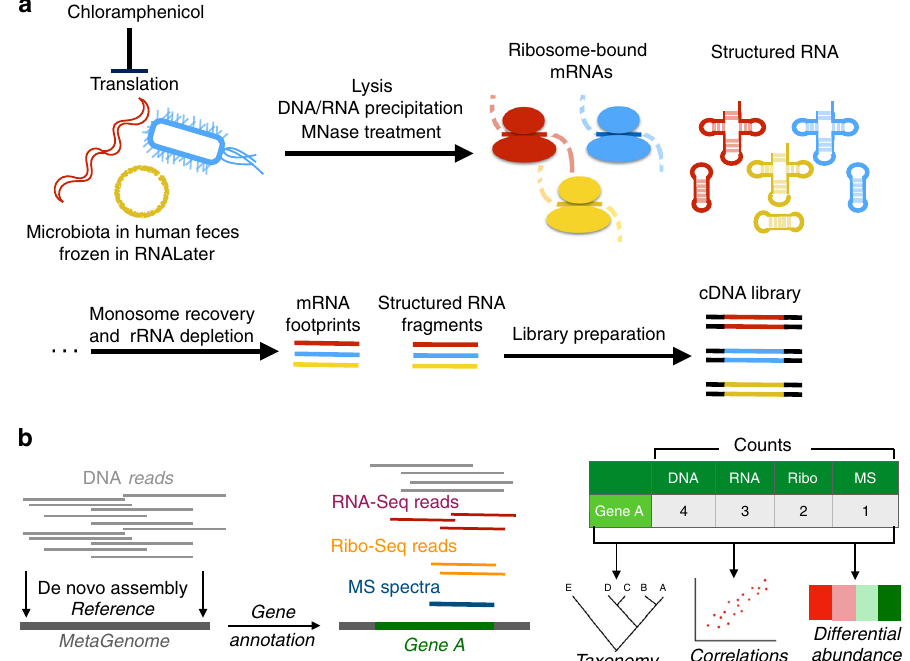
Fig. 1 Work fl ow of ribosome pro fi ling. a Experimental work fl ow of MetaRibo-Seq. Chloramphenicol halts translation, bacteria within the community are lysed, MNase is used to create footprints, and footprints are converted to sequencing libraries. b Computational work fl ow of the multi-omics approach. De novo assemblies are created and annotated, predicted genes are quanti fi ed at multi-omic levels, and taxonomy, correlations, and differential abundance are determined from these